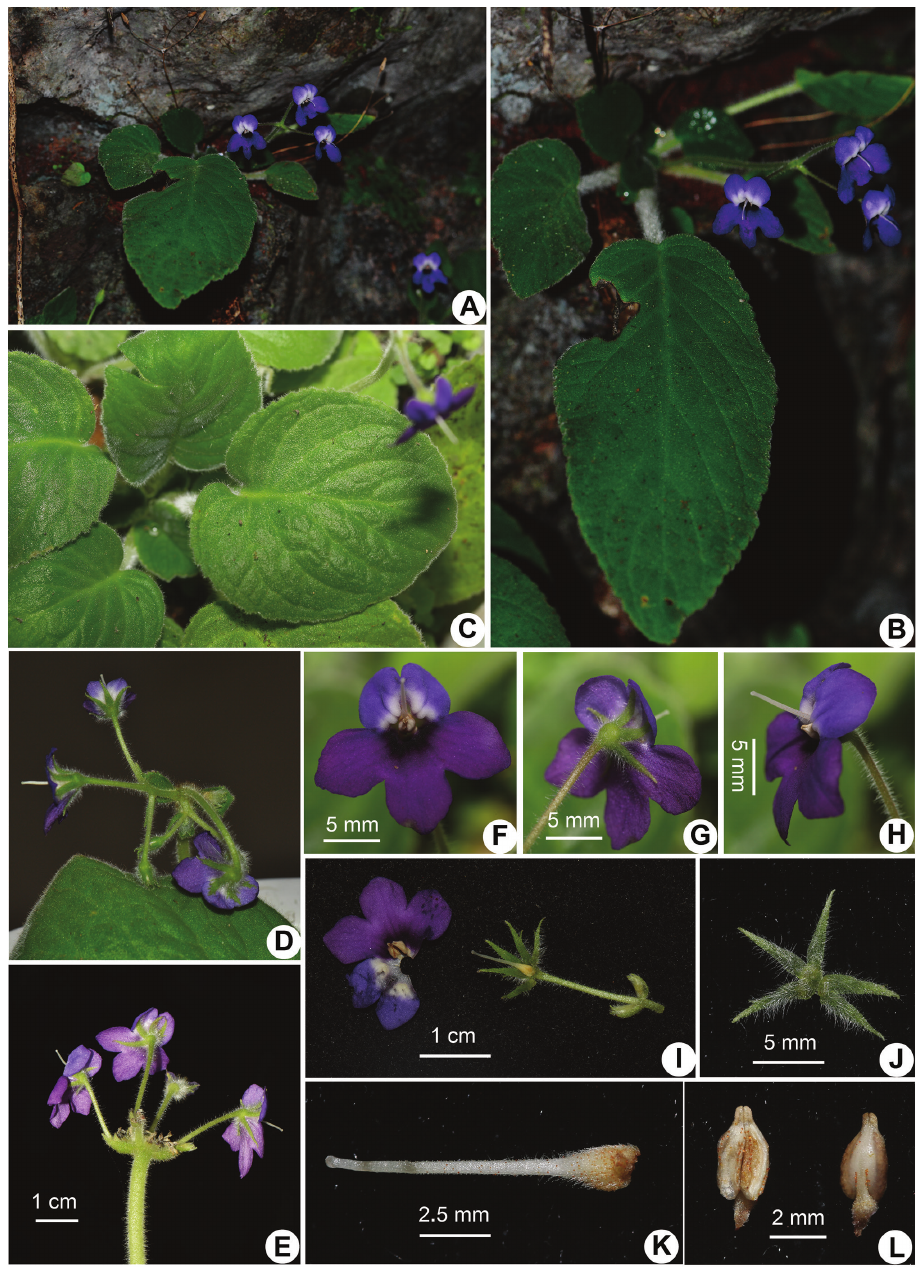
Figure 3. Petrocosmea tsaii Y.H.Tan & JianW.Li, sp. nov. A, B Habit C leaves D, E inflorescence F flower in front view G flower in back view H flower in side view I dissected flower J calyx in abaxial view K pistil L stamens. Photographed by J.W.Li, Y.H.Tan &